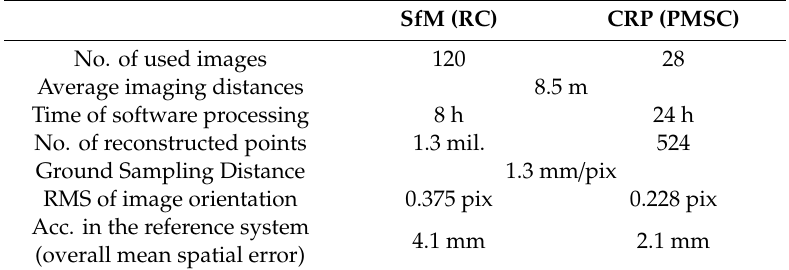
Table 1. Parameters of imaging and image processing by photogrammetric methods.